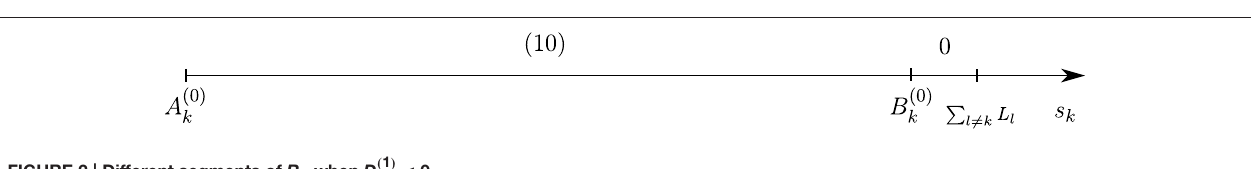
FIGURE 2 | Different segments of R k when D ( 1 ) k ≤ 0.